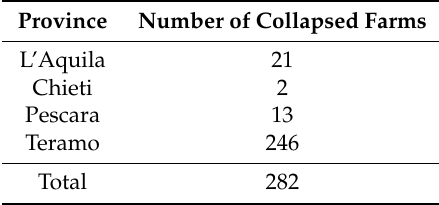
Table 1. Distribution of the farms that reported collapsed stables in the territory of Abruzzo region.